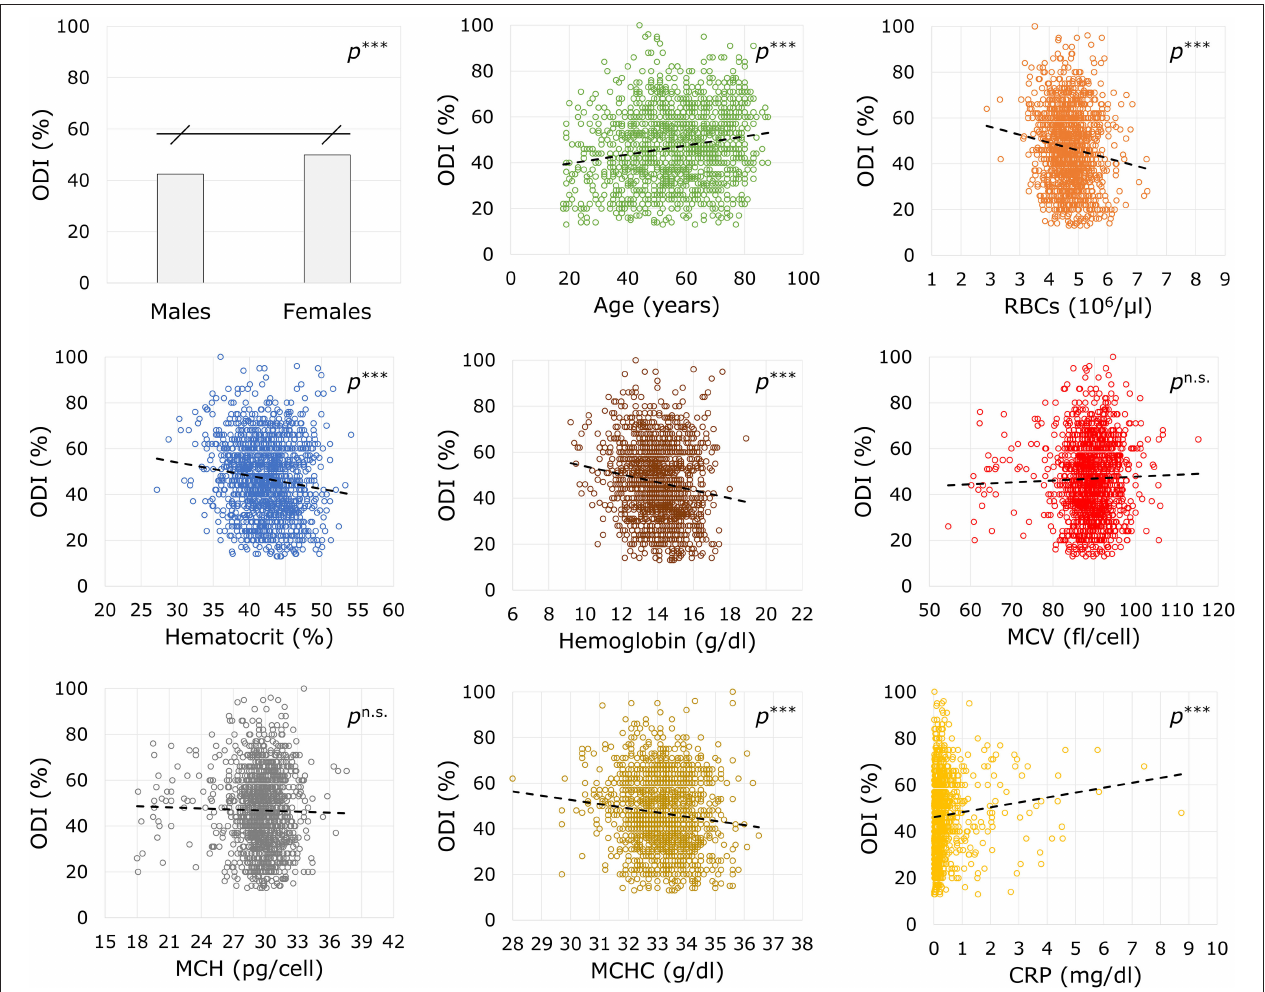
FIGURE 1 | Associations between demographic and biochemical variables with the disability index before surgery. ODI, Oswestry Disability Index, ranging from 0 (no disability) to 100 (maximum disability); RBCs, red blood cells; MCV, mean corpuscular volume; MCH, mean corpuscular hemoglobin; MCHC, mean corpuscular hemoglobin concentration; CRP, C-reactive protein. Statistics: *** p < 0.001; n.s. p not